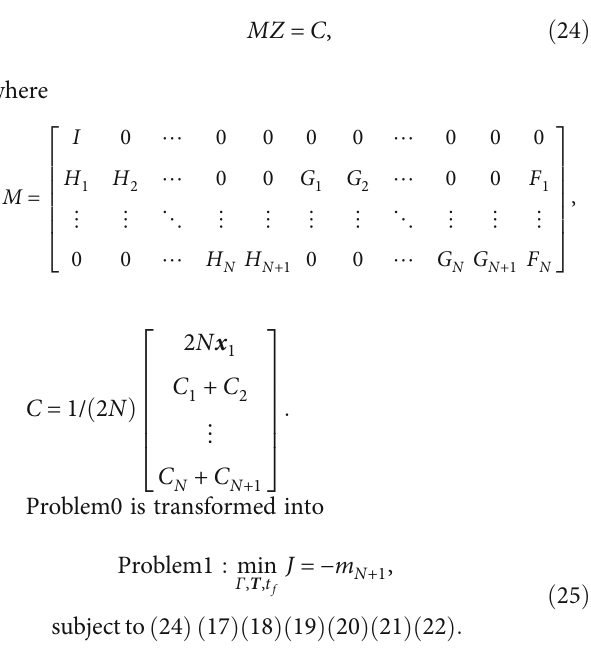
Figure 2: Solution steps for the trajectory optimization